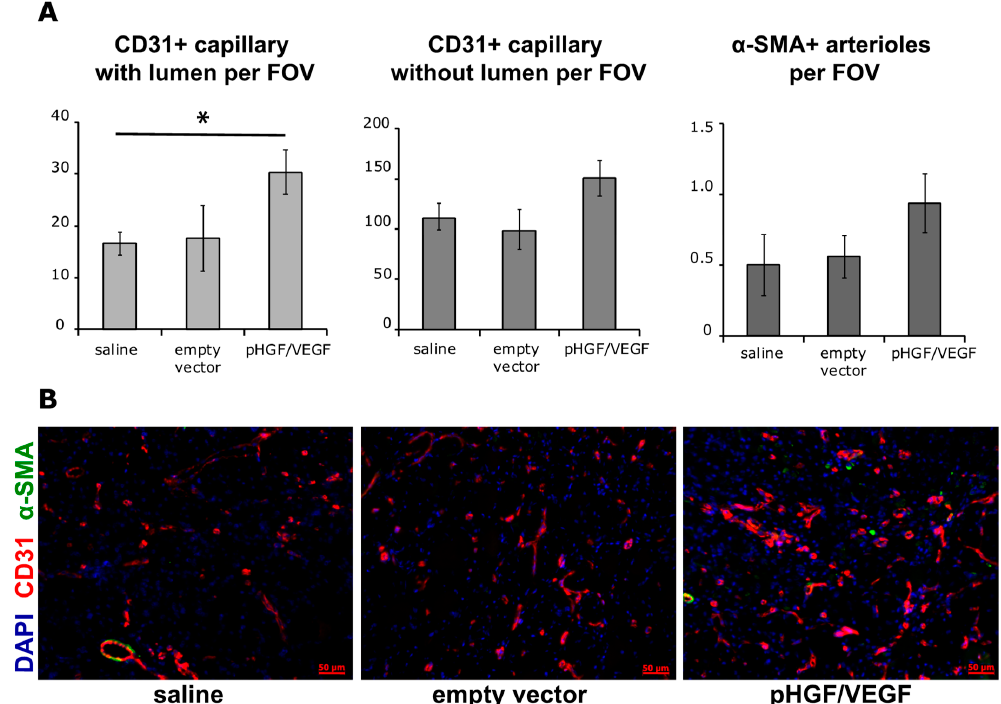
Figure 9. Analysis of blood vessel density in skeletal muscle sections from study group animals. ( A ) Graphical presentation of blood vessel density analysis with average group values per FOV: CD31 + capillaries with lumen, CD31 + capillaries without lumen and α -SMA + vessels. * p < 0.05 for pHGF / VEGF vs. saline group. Data are presented as mean ± SEM. ( B ) Representative image of muscle section stained for CD31, α -SMA and 4 ′ ,6-diamidino-2-phenylindole (DAPI) (magnification × 200). Scale bar represents 50 μ m.